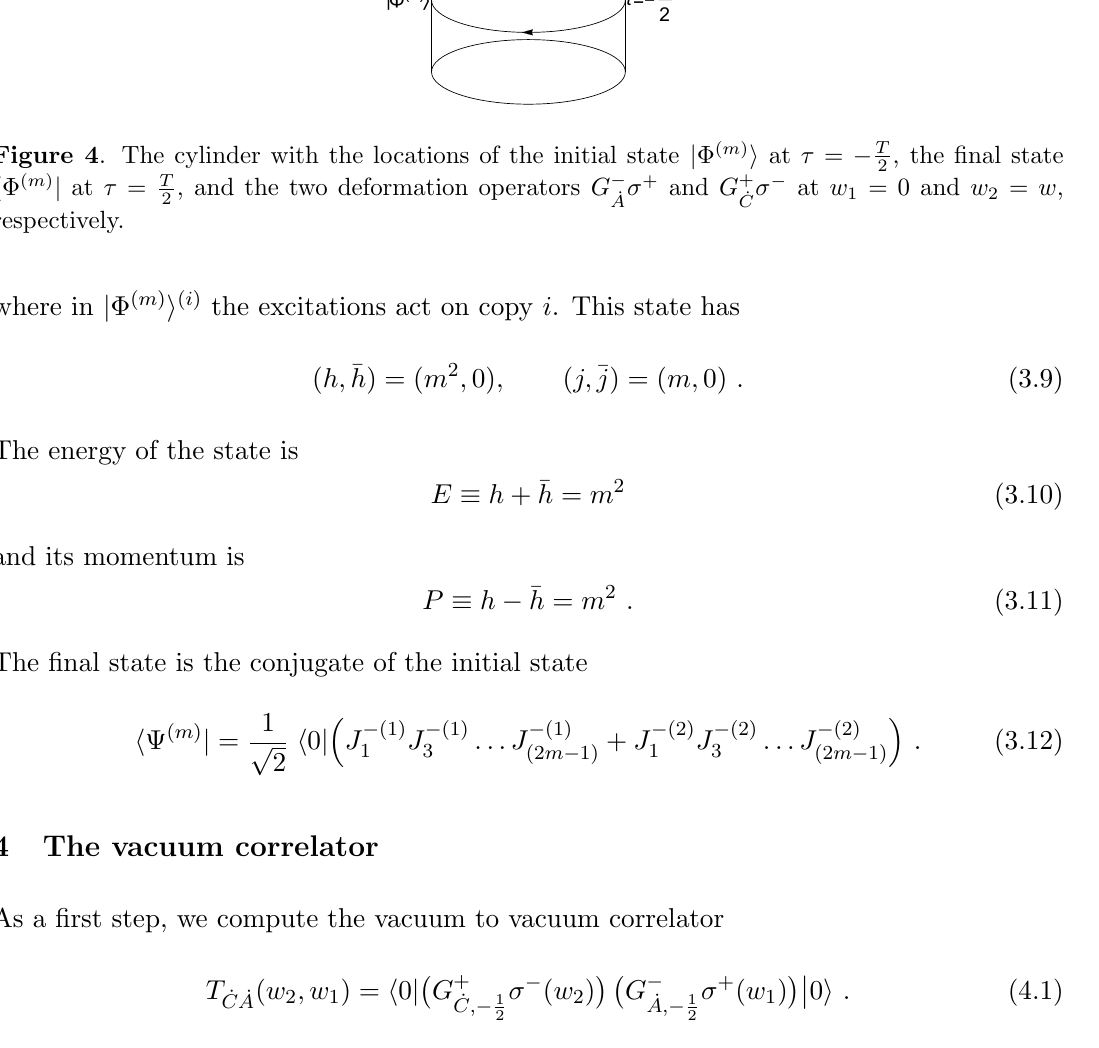
, and the two deformation operators G (cid:0) 2